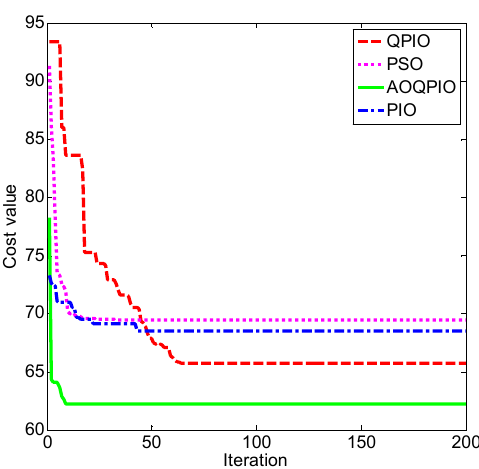
Figure 8. The comparative curves of iteration of the algorithms of the experiment carried out in map 3.